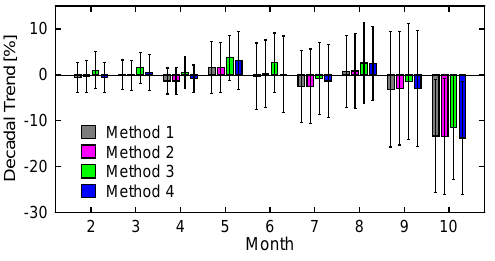
Fig. 3. Comparison of trends and their uncertainties of irradiance at 345nm obtained for the four data sets discussed in the text. Method 1 is based on the uncorrected dataset. Methods 2–4 apply correc- tion factors based on ratios of clear sky measurements and model calculations that were averaged over annual (Method 2), summerly (Method 3) and monthly (Method 4)